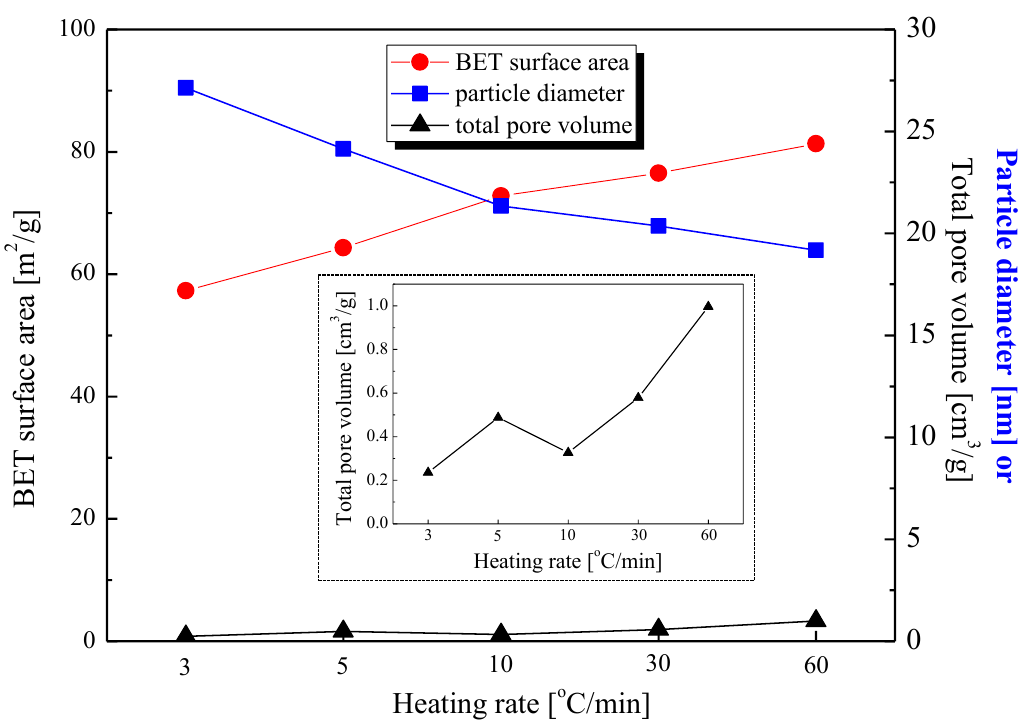
Figure 7. BET surface area, total pore volume, and particle diameter measured from the BET surface area data for the Ag–TiO 2 nanocomposite films annealed at 600 ºC with heating rates of 3-60 ºC/min.